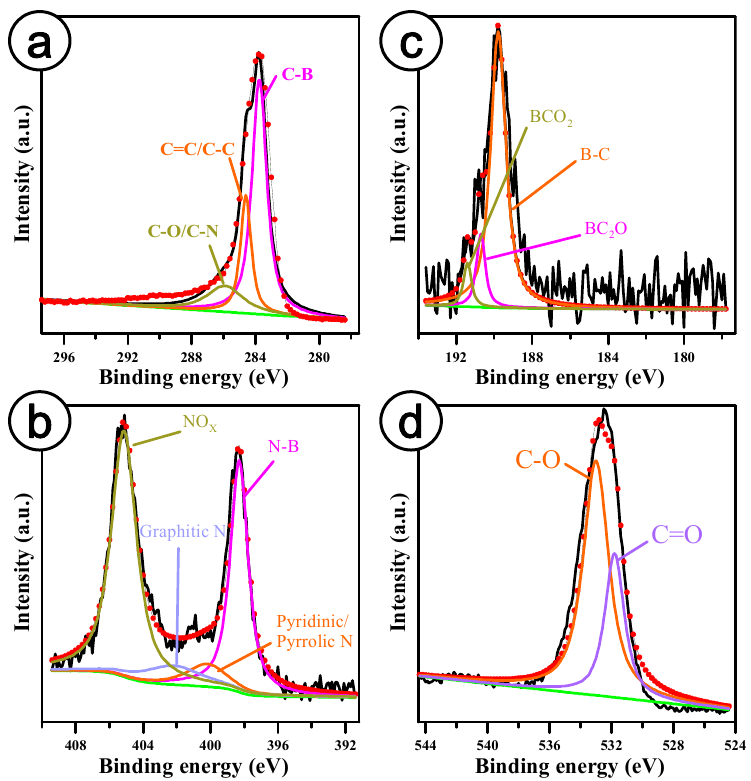
Figure 4. XPS spectra of ( a ) C 1s, ( b ) N 1s, ( c ) B 1s, and ( d ) O 1s peaks of B-N-codoped GQD = coated electrodes.